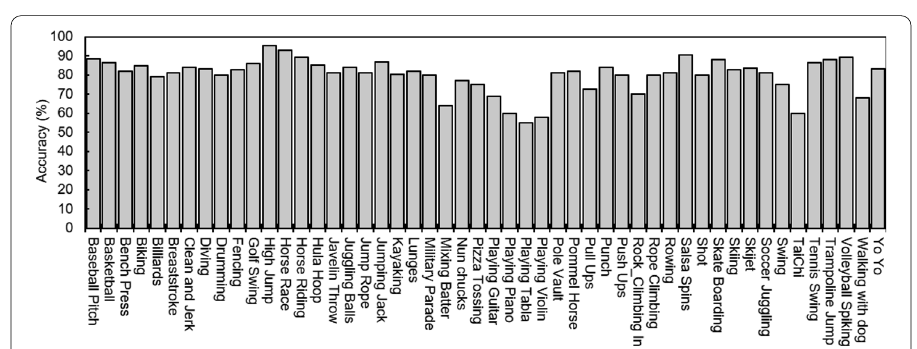
Fig. 14 The detailed accuracy by class for the UCF50